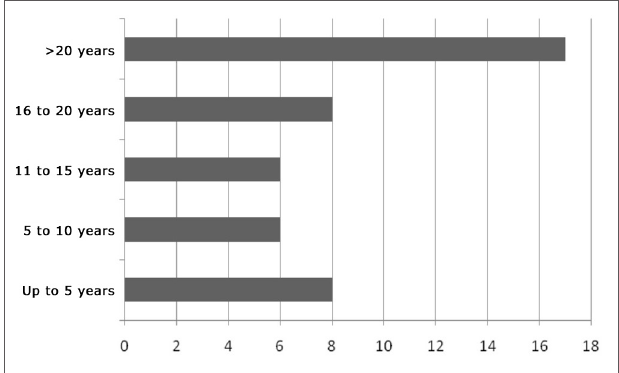
Figure 3. Number of patients according to ear disease